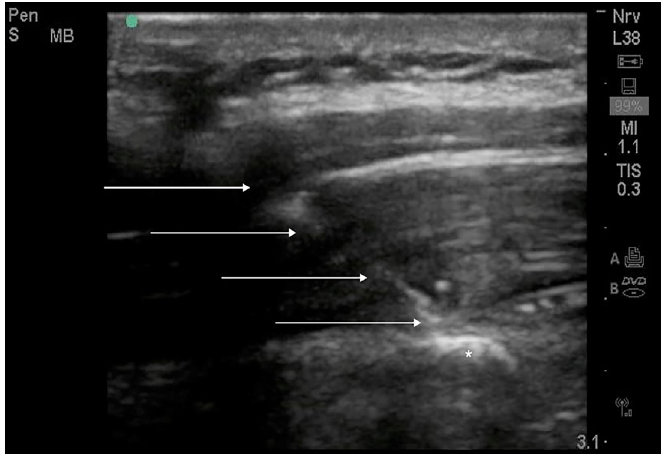
Image 2. In-plane approach: advancing the needle tip (arrows) through the erector spinae muscle to the posterior surface of the transverse process of the first lumbar vertebra